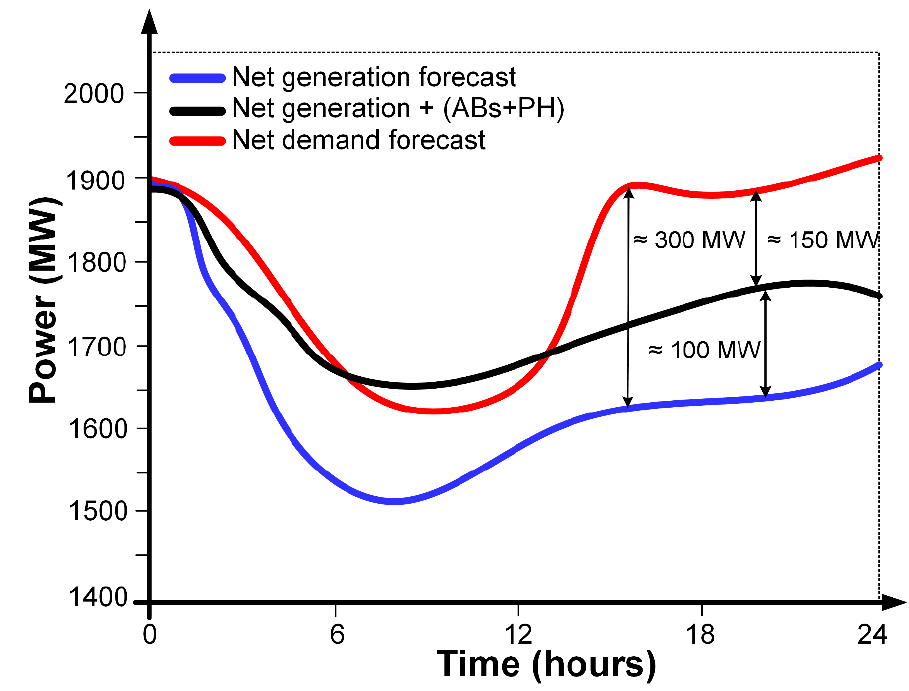
Figure 10. Analysis of energy generation and demand of the North Baja California region.